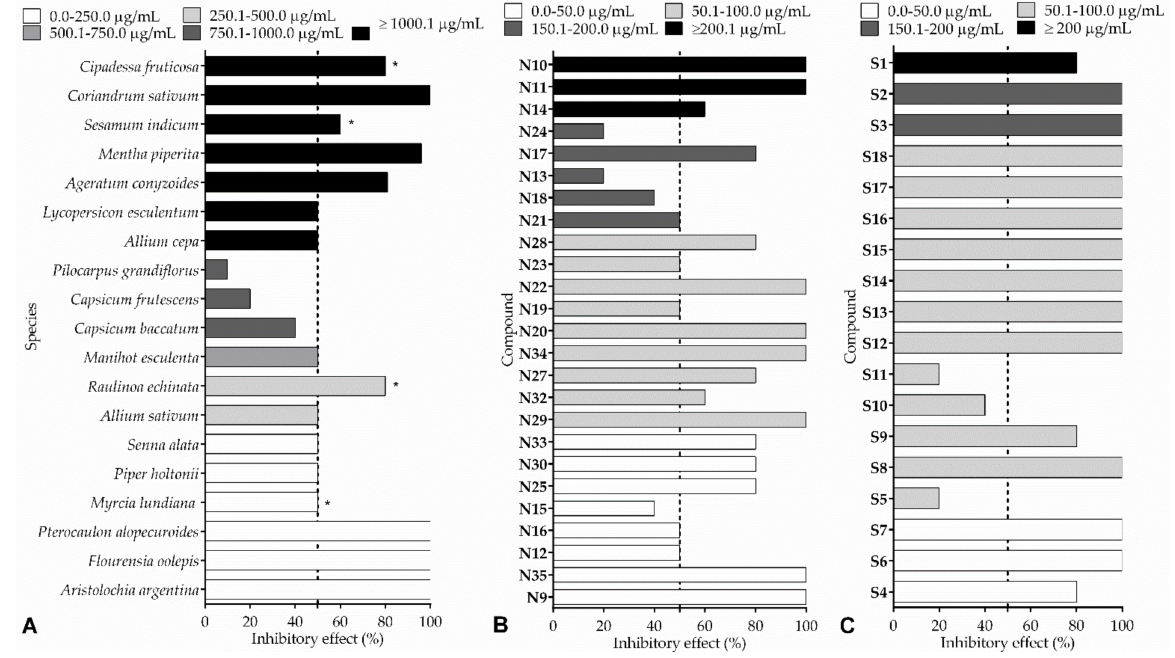
Figure 4. Relationship of the percentage of inhibitory effect on Leucoagaricus gongylophorus growth according to the concentration of extracts ( A ), isolated natural compounds ( B ), and synthetic com- pounds ( C ). Graph obtained only from results expressed as a percentage inhibitory effect. Other data expressions were excluded due to the difficulty of comparison, but can be found in Tables 1–4. * The most active extract was selected for species with more than one type of